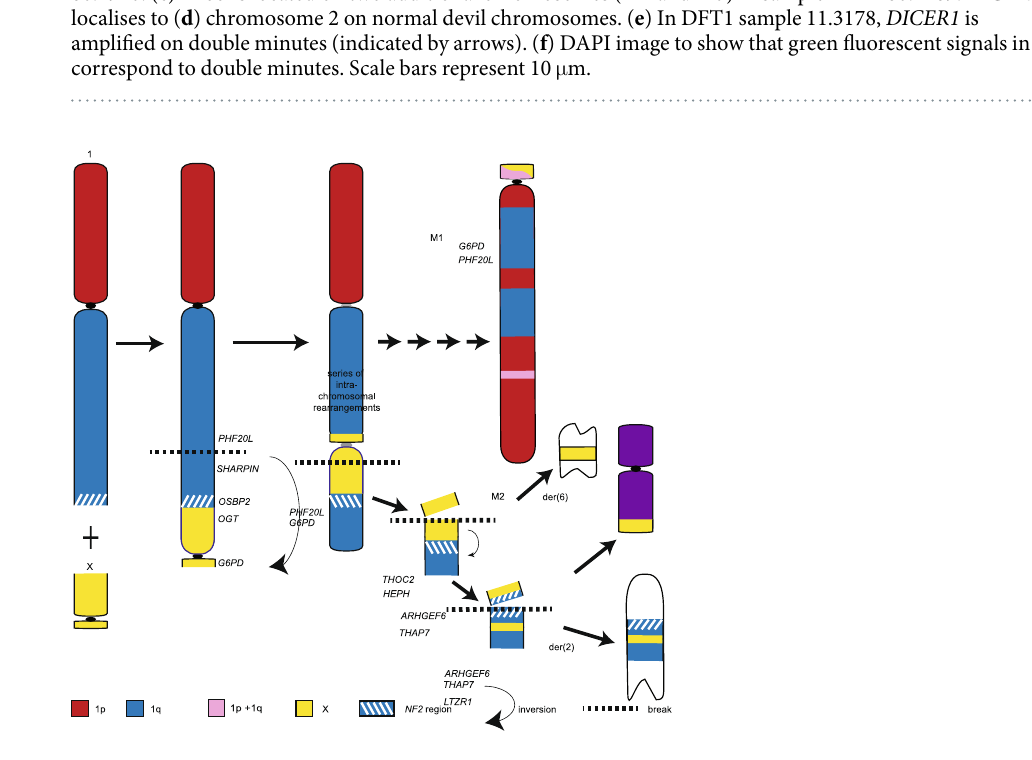
Figure 7. Proposed scenario for the fusion of chromosome 1 and X leading to the formation of marker chromosome 1. A loss of telomeres from 1q (adjacent to the NF2 region) permitted the fusion with the X chromosome, which had also experienced telomere loss. The resulting dicentric chromosome broke between the PHF20L and SHARPIN genes, permitting an inversion of region around the 1q/X fusion. A further break led to the region around the original 1q/X fusion containing the NF2 region breaking away from M1. After a break permitting the translocation of the fragment containing THOC2 and HEPH to M2, a further inversion around the NF2 region brought THAP7 from 1q and ARHGEF6 from Xq together. These genes then translocated to derivative chromosome 6 whereas the remaining segment translocated to derivative chromosome